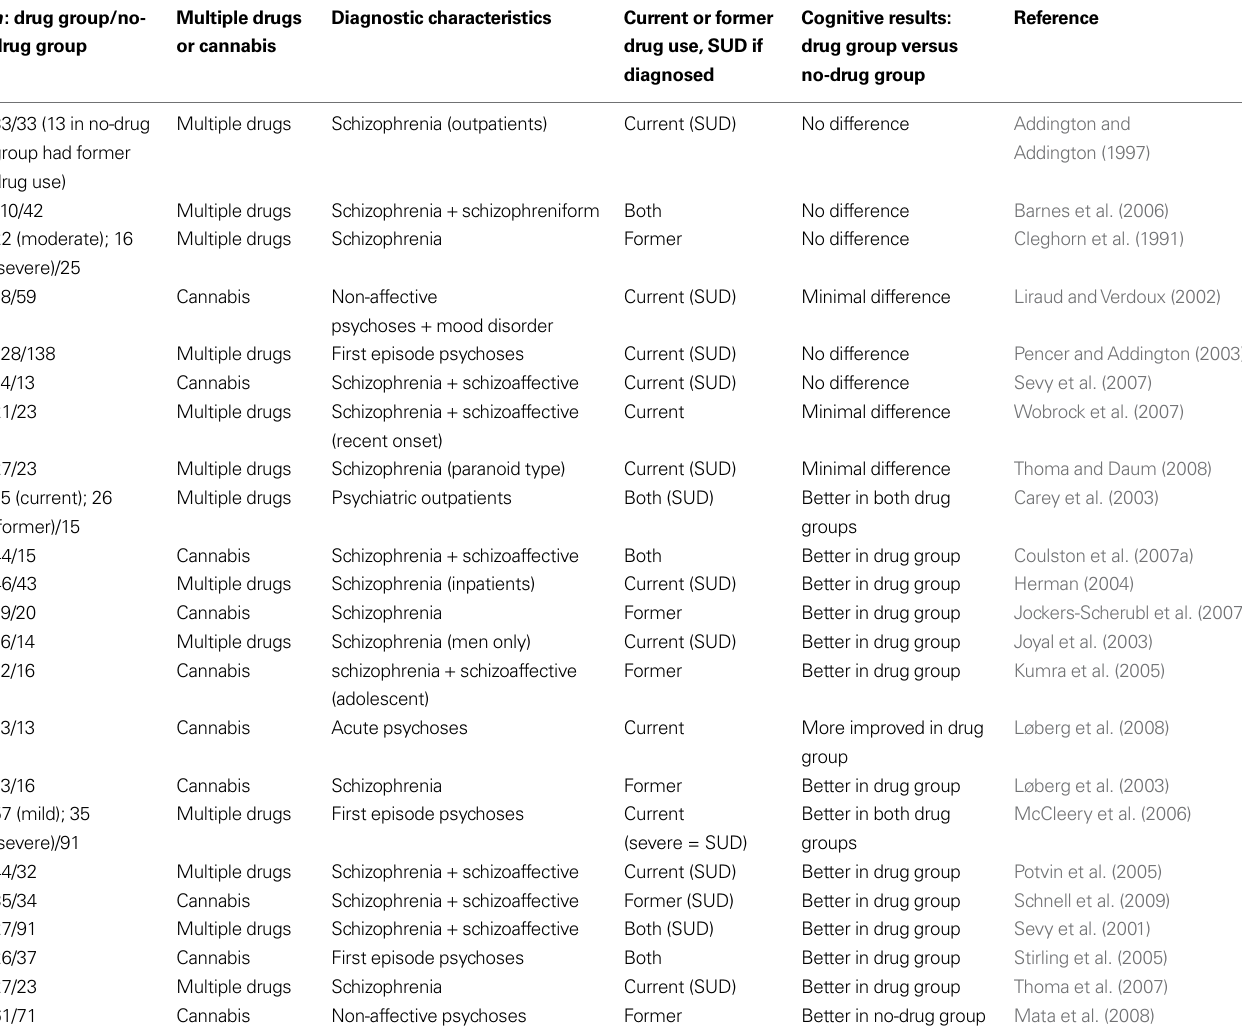
Table 1 | Overview of 23 studies on the effects of cannabis/drug use in schizophrenia and related psychoses on cognition by n, drug type, diagnoses, type of drug use, and